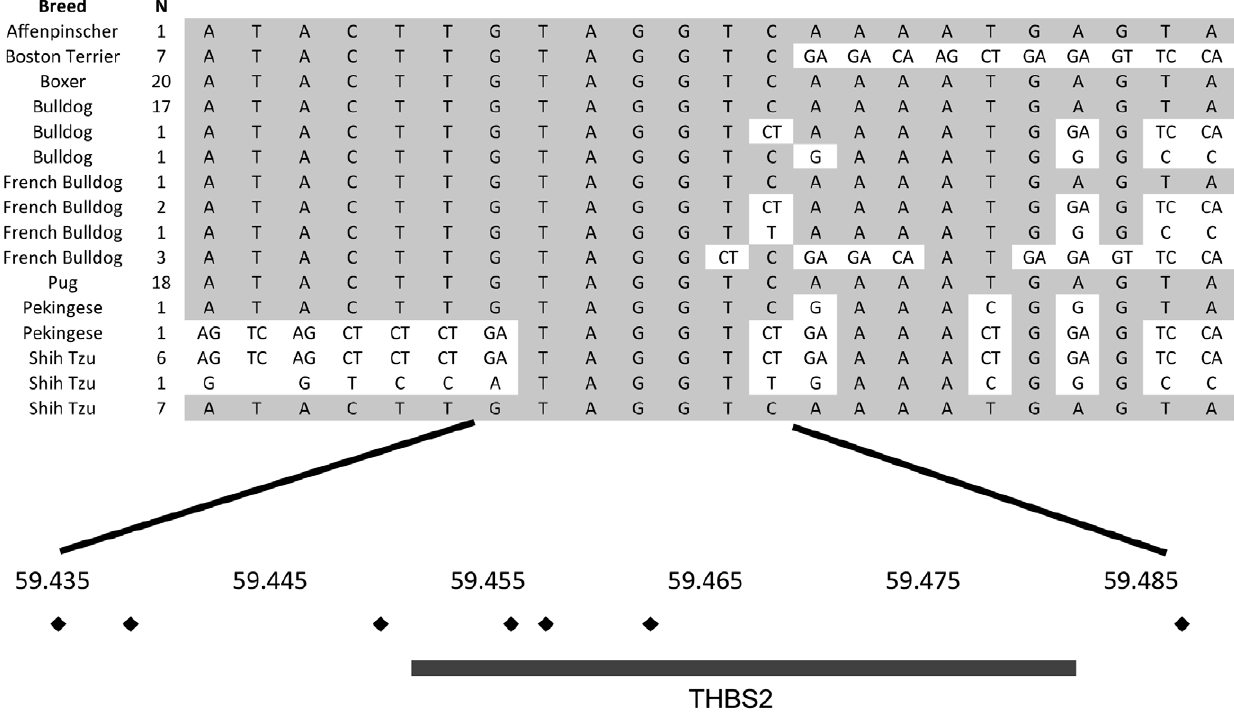
Figure 5. Fine mapping using haplotype analysis for brachycephaly. Haplotypes identified in affected dogs are shown. The breeds (Breed) and number of individuals (N) with each haplotype are shown on the left. In the bottom panel the relative position of the genotyped SNPs (black diamonds) is shown along with the location of the gene (solid bar) in the region.